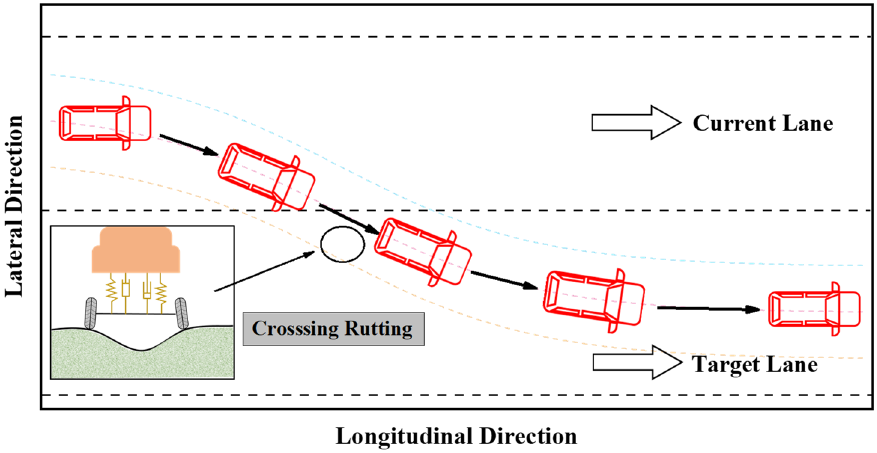
Figure 7. Diagram of lane-change trajectory.